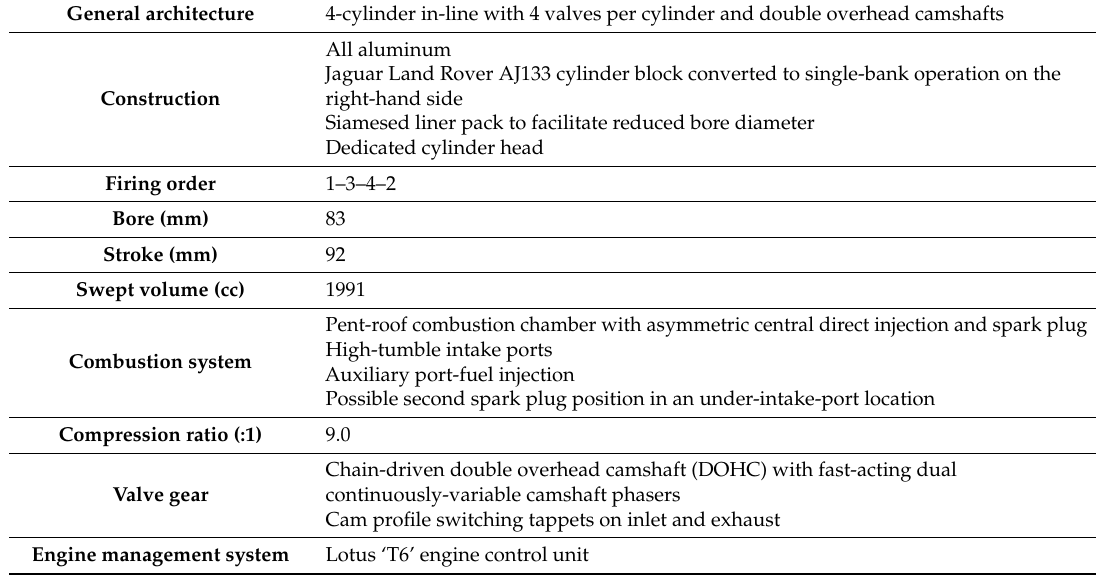
Specifications of the Ultraboost extreme downsizing demonstrator engine in the externally-boosted “UB100” configuration, as used for the fuel blends testing reported here [41]. General